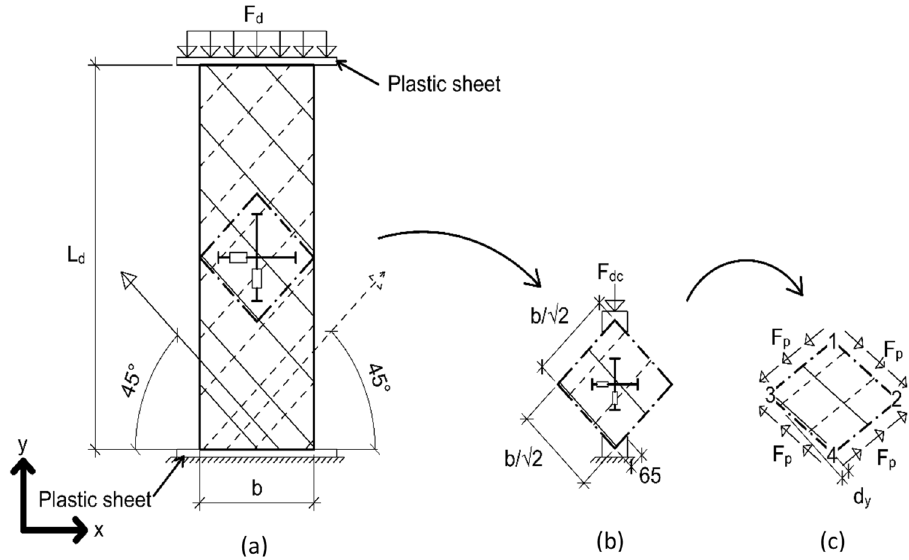
Fig. 1 Diaphragm shear simu- lation a , diagonal compression simulation b , and pure shear simulation c . The measured zone is illustrated by the transducers in the centre of the diaphragm shear simulation and diagonal compression sim- ulation models. The arrows in a show the main laminate direc- tions of the odd (solid line) and even (dashed line) layers. The dash-dotted line illustrated in the CLT panel a shows the simulated area in diagonal compression simulations and pure shear simulations